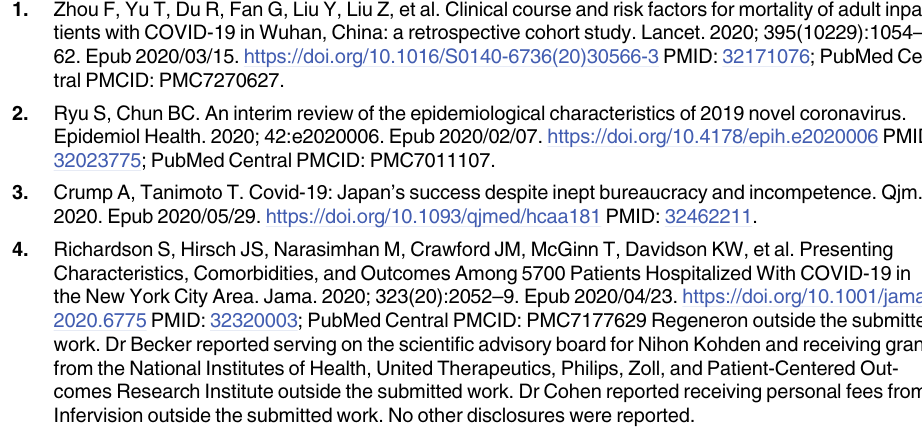
S1 Table. Characteristics, treatments, and prognosis in Group M. BMI: body mass index; GERD: gastroesophageal reflux disease; CKD: chronic kidney disease; CHF: congestive